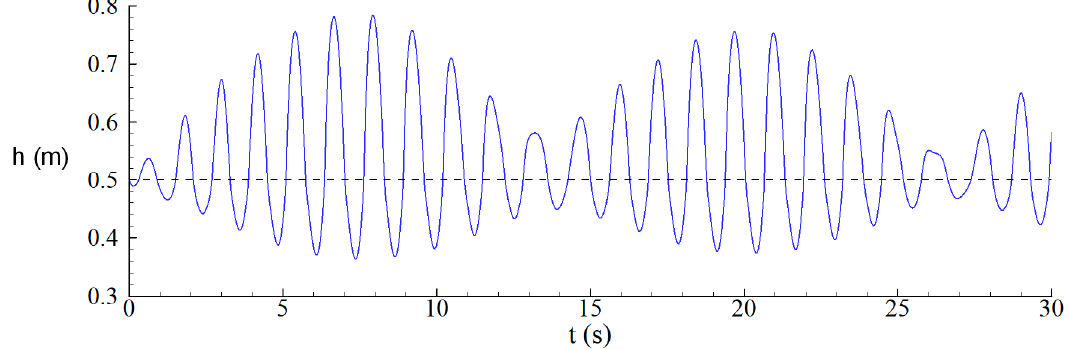
Figure 3. Time variation of the water depth at the left wall during the sinusoidal oscillation of the tank. The dashed line represents the initial water level in the tank.